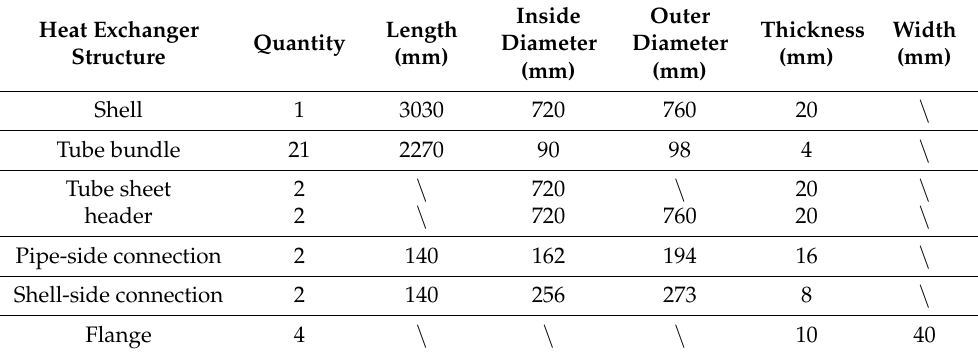
Figure 1. Schematic diagram of the internal structure of the superheater of the steam generation system of the 50 MW trough molten salt CSP station. Table 1. Structural parameters of superheater in steam generation system of 50 MW trough molten salt solar thermal power station.